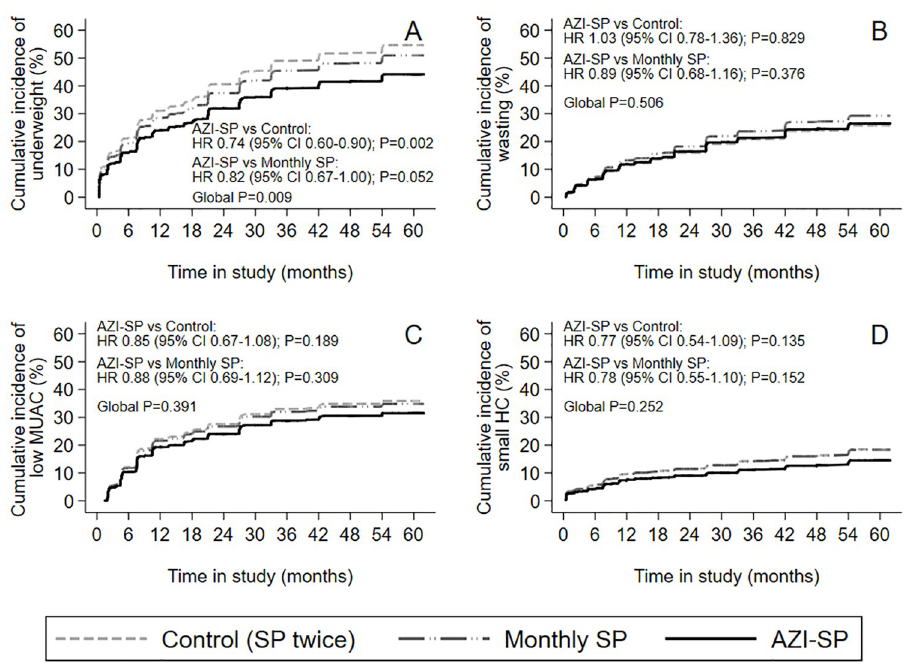
Fig 5. Cumulative incidence of underweight, wasting, low mid-upper arm circumference, and small head circumference. Under competing risk of death by 60 months of age by intervention group. (A) Underweight defined as weight-for-age Z < -2. (B) Wasting defined as weight-for-height Z (WHZ) < -2. (C) Low mid-upper arm circumference (MUAC) defined as MUAC-for-age Z < -2. (D) Small head circumference (HC) defined as HC-for- age Z < -2. SP = sulfadoxine-pyrimethamine; AZI-SP = intervention group with monthly SP and two doses of azithromycin; HR = hazard ratio. � denotes P < 0.05 between AZI-SP and the control group.